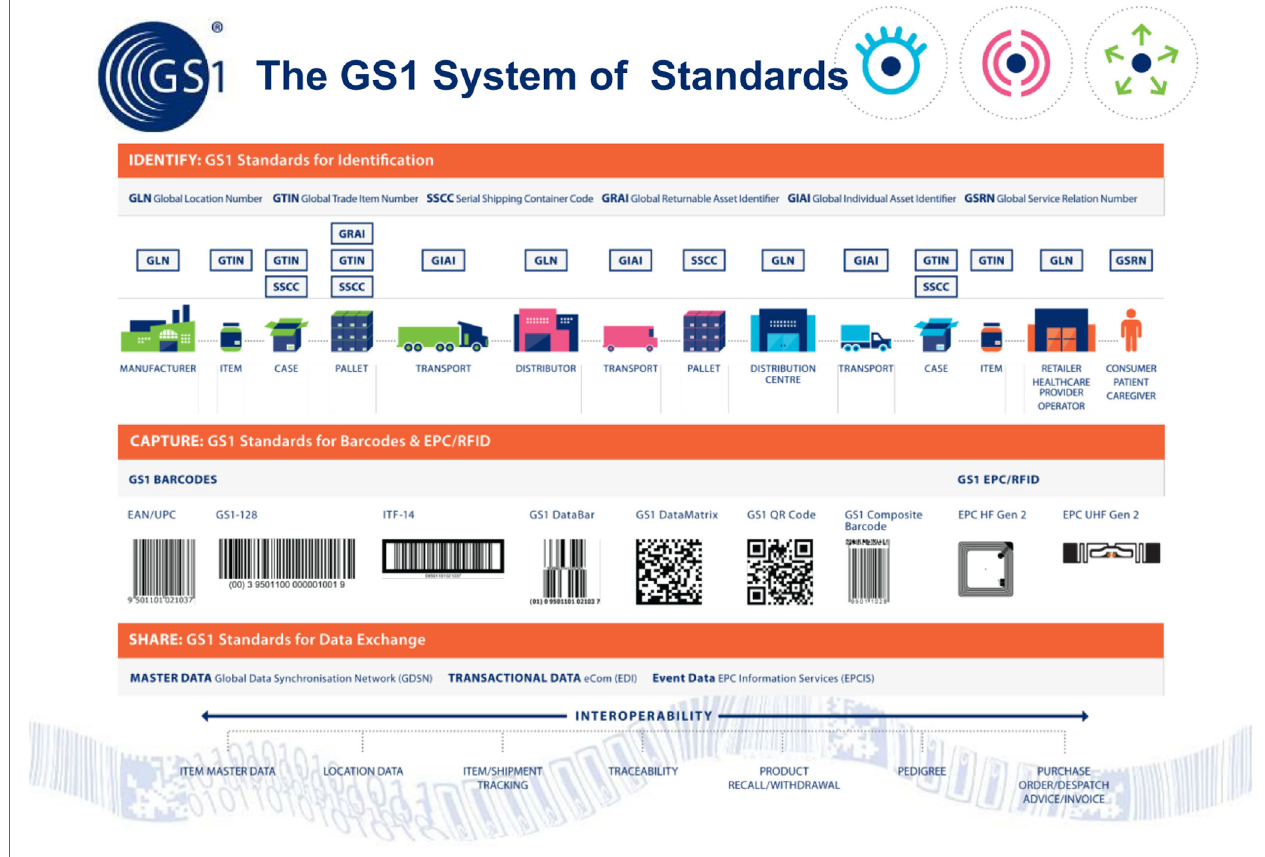
FiGuRE 1 | How GS1’s global standards work to move data between the various supply chain partners, thereby linking the physical flow of goods to the electronic data associated with